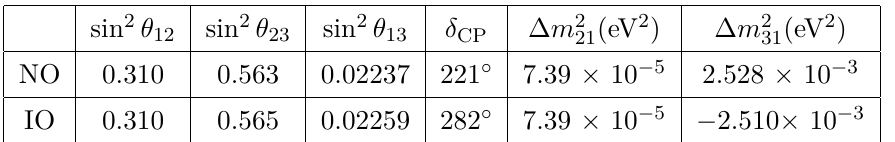
Table 2 . Benchmark oscillation parameters for NO and IO, taken from the NuFit v4.1 result [36].